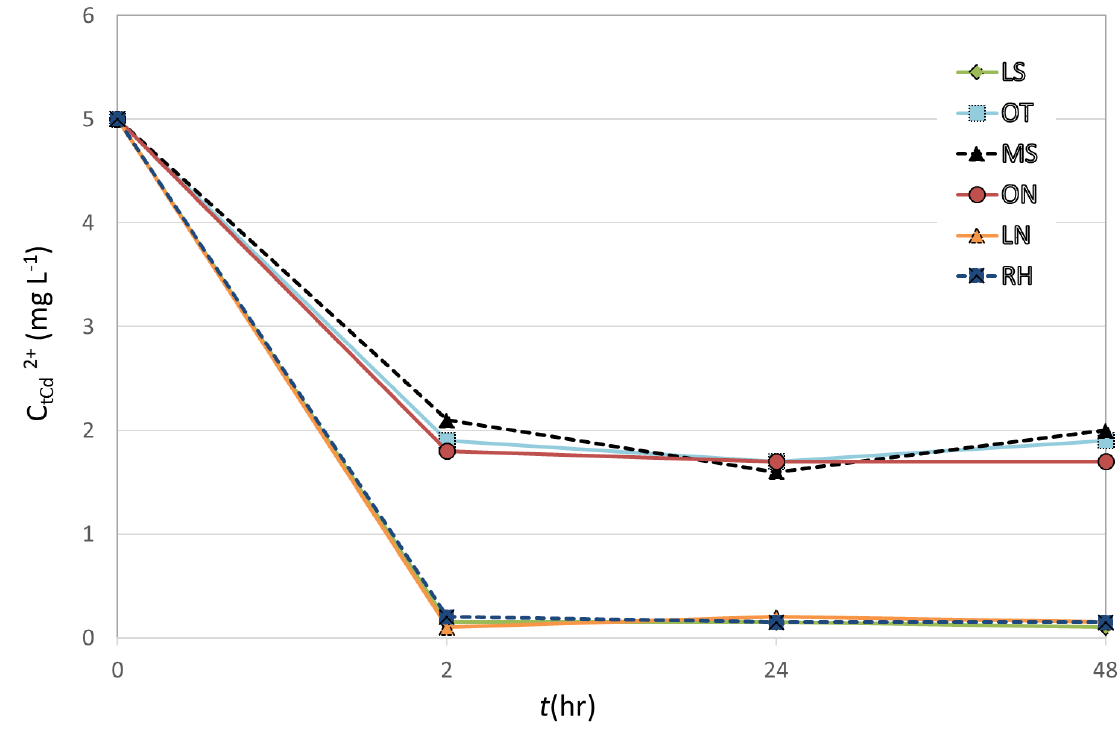
Figure 1. Kinetic curves showing change in the concentration of Cd in solution (C tCd2+ , mg L -1 ) with time ( t , hr) for a C 0Cd2+ of 5 mg L -1 , for each of the six peat types tested. Note that the scale on the horizontal axis is not